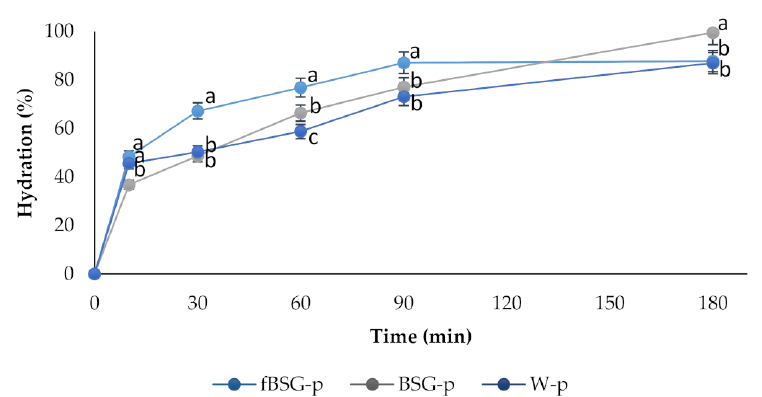
Figure 1. Kinetics of water absorption of pasta at 25 ◦ C. BSG-p, pasta containing native brewers’ spent grains (15% wt/wt in replacement of semolina); fBSG-p, pasta containing fermented brewers’ spent grains (15% wt/wt in replacement of semolina); W-p, pasta made with durum wheat semolina. Data are the means of three independent analyses. a–c Values with different superscript letters within the same time, differ significantly ( p < 0.05). Bars of standard deviations are also